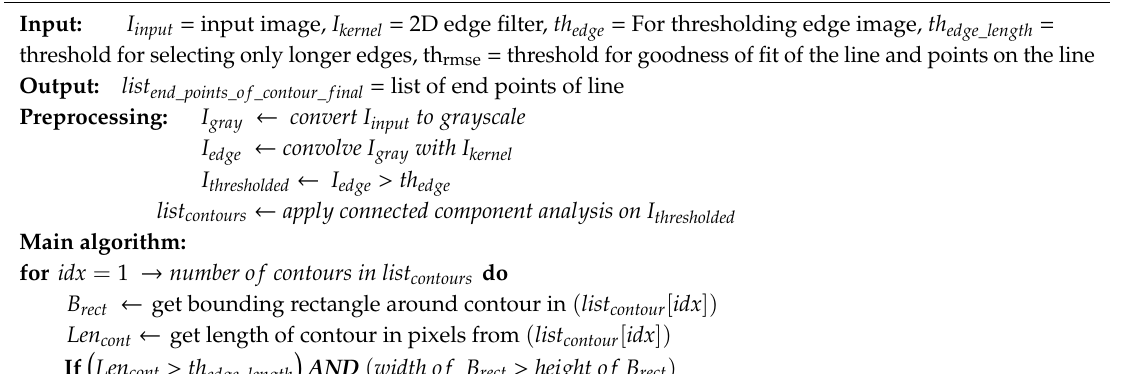
Algorithm 1 Power Line